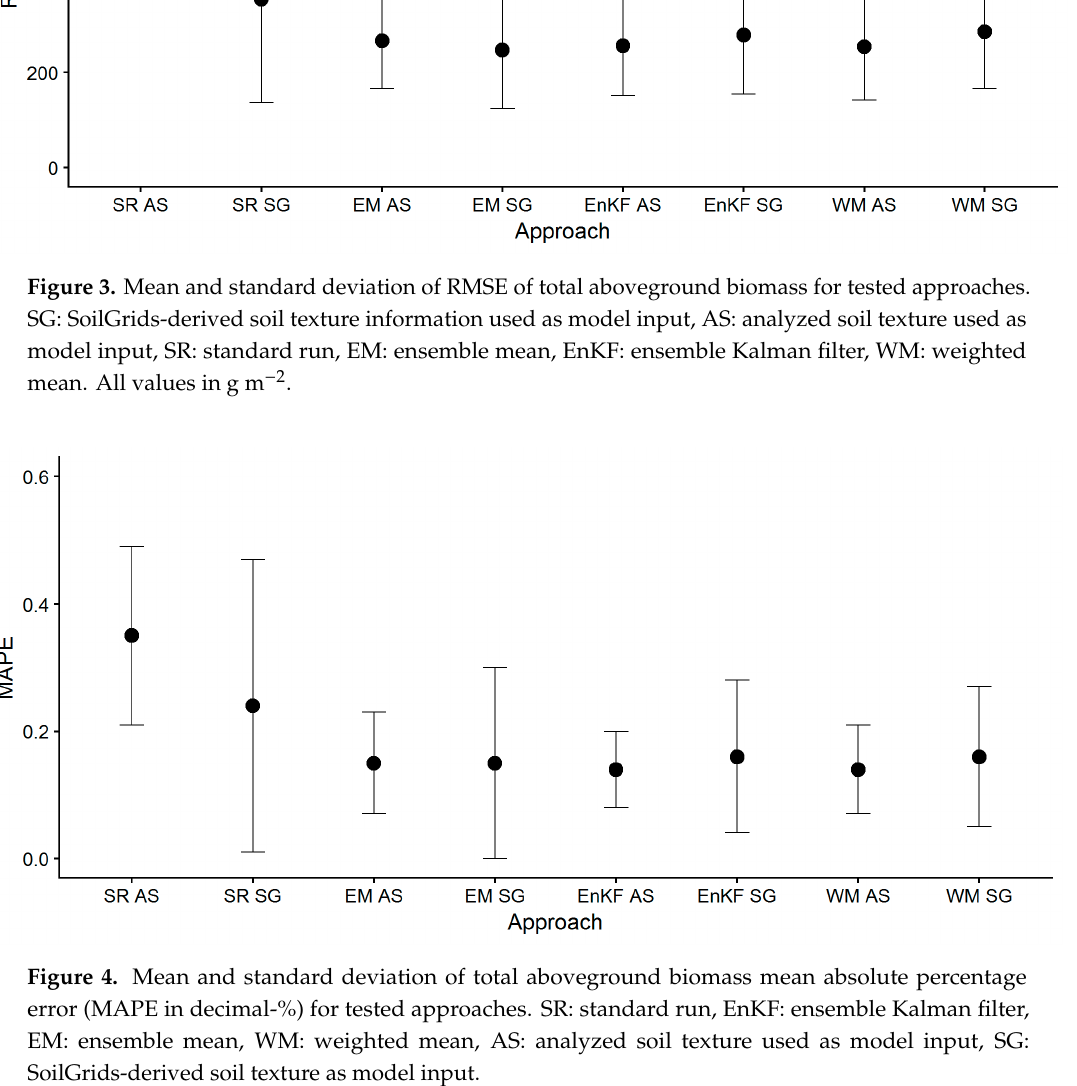
Figure 5 . Average bias and standard deviation of total aboveground biomass for tested approaches. SR: standard run, EM: ensemble mean, EnKF: ensemble Kalman filter, WM: weighted mean, AS: